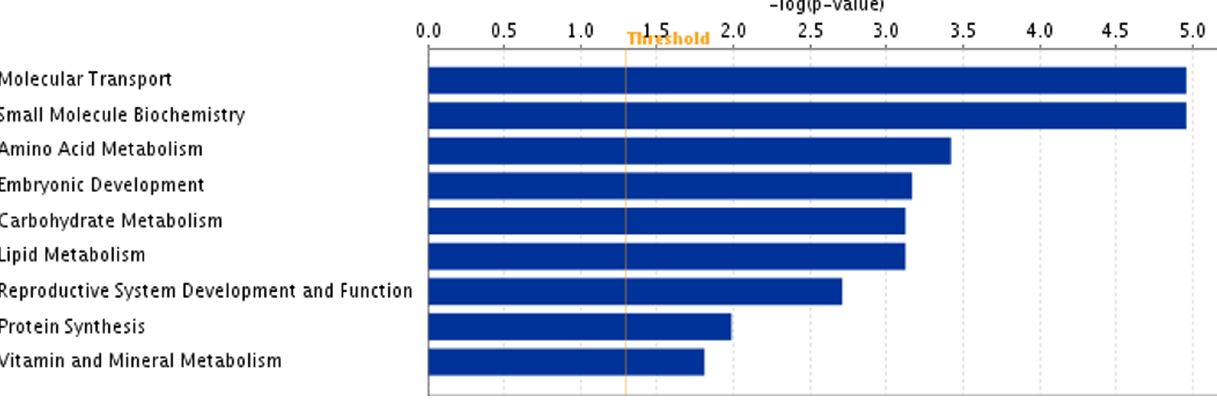
Figure 2. Functional grouping of DEGs in testis with high and low androstenone using Ingenuity Pathways Analysis (IPA) software. The most significant functional groups ( p , 0.05) are presented graphically. The bars represent the p -value on a logarithmic scale for each functional group. doi:10.1371/journal.pone.0063259.g002 PLOS ONE |